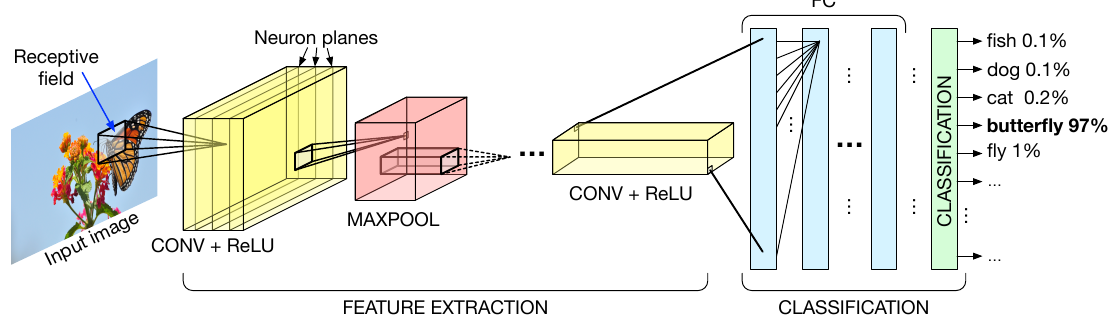
Figure 5. Convolutional Neural Networks (CNNs) are composed of different 3D layers. Each layer extracts different features from the input